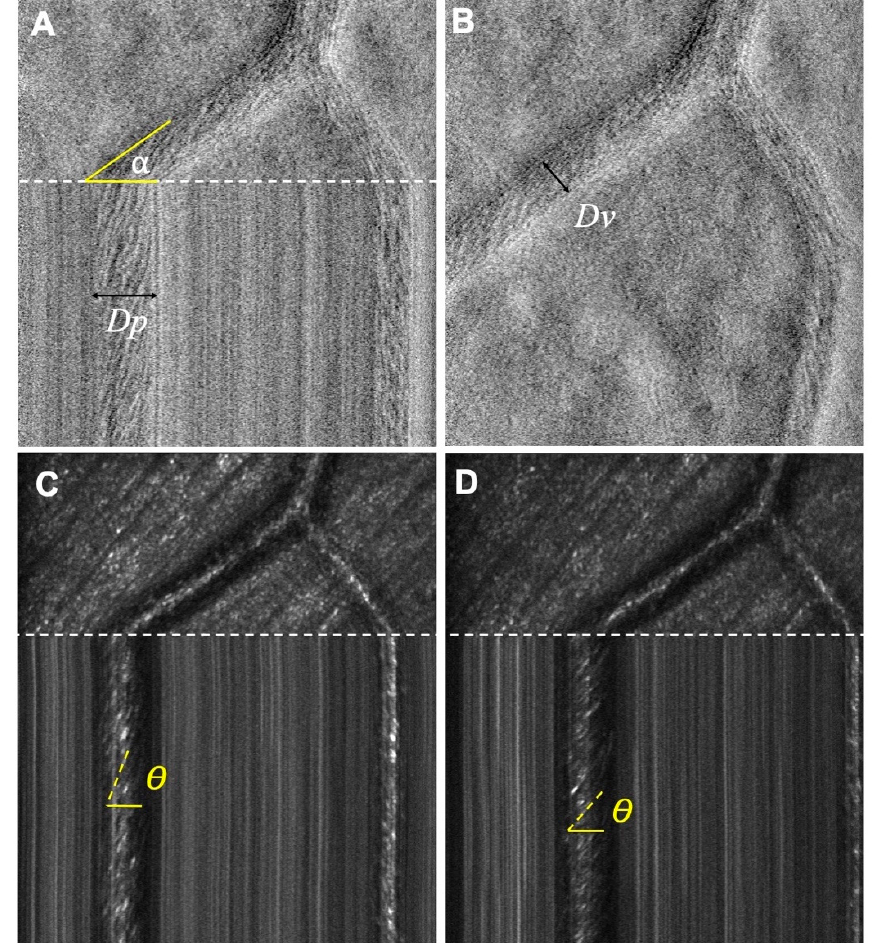
Figure 1. Adaptive Optics Scanning Laser Ophthalmoscopy (AOSLO) split-detector and confocal images. ( A ) Single-frame split-detector images showing XT image with the scan intersecting the blood vessel at angle alpha. The vessel lumen width was determined from the XT scan ( Dp ). ( B ) XY image showing the direct diameter of the vessel ( Dv ). ( C , D ) AOSLO confocal images showing the theta angle of RBC slopes at different phases of the cardiac cycle. Shallower slopes indicate higher velocity.